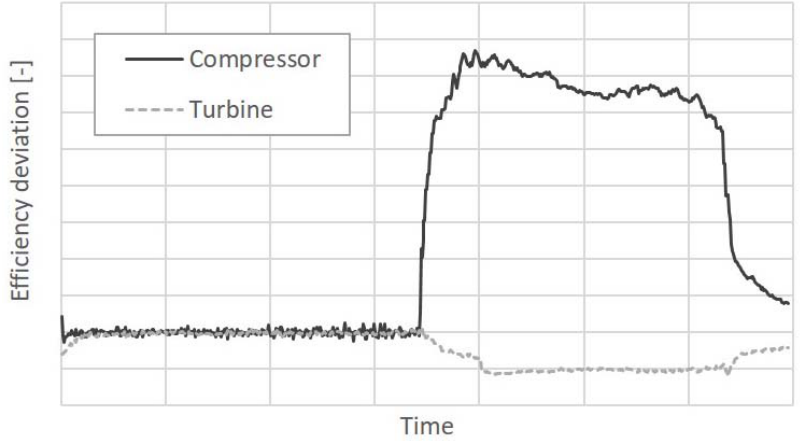
Figure 9. Estimated compressor and turbine efficiency deviations in day 21 of Scenario 2.